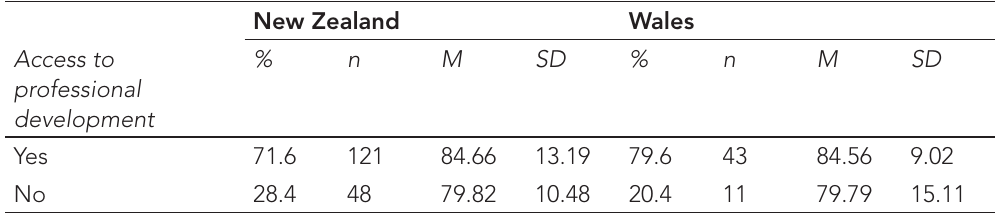
Table 3. Mentor access to professional development New Zealand